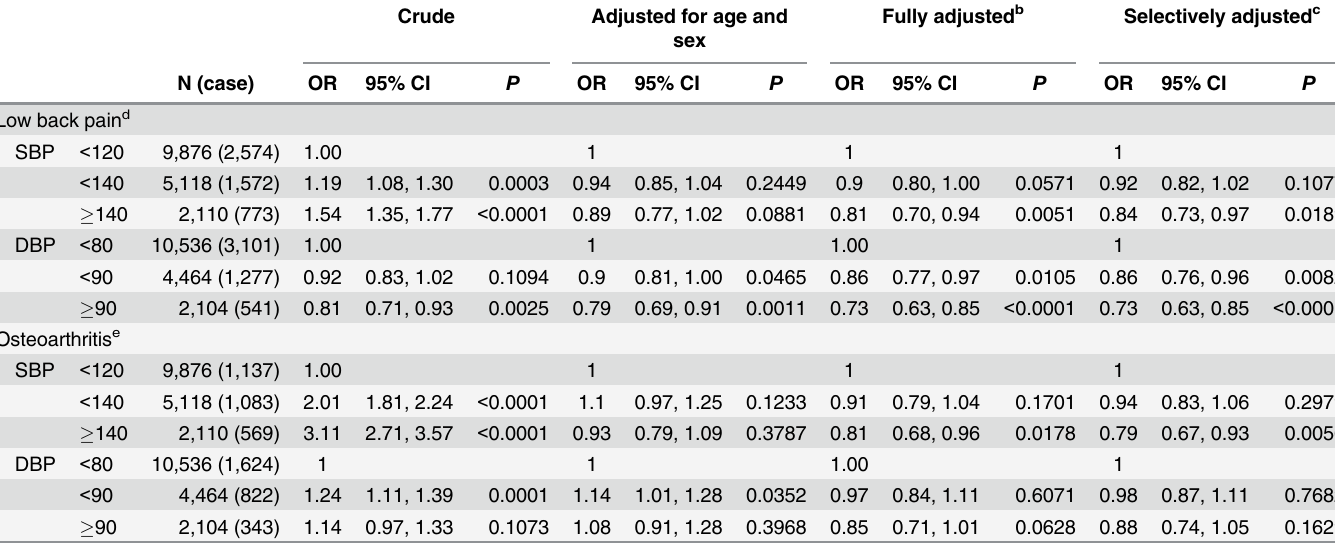
Table 3. Associations Between Systolic and Diastolic Blood Pressure and Low Back Pain or Osteoarthritis in Korean Surveyees of KNHANES IV aged (cid:1) 20 years a . Crude Adjusted for age and Fully adjusted sex